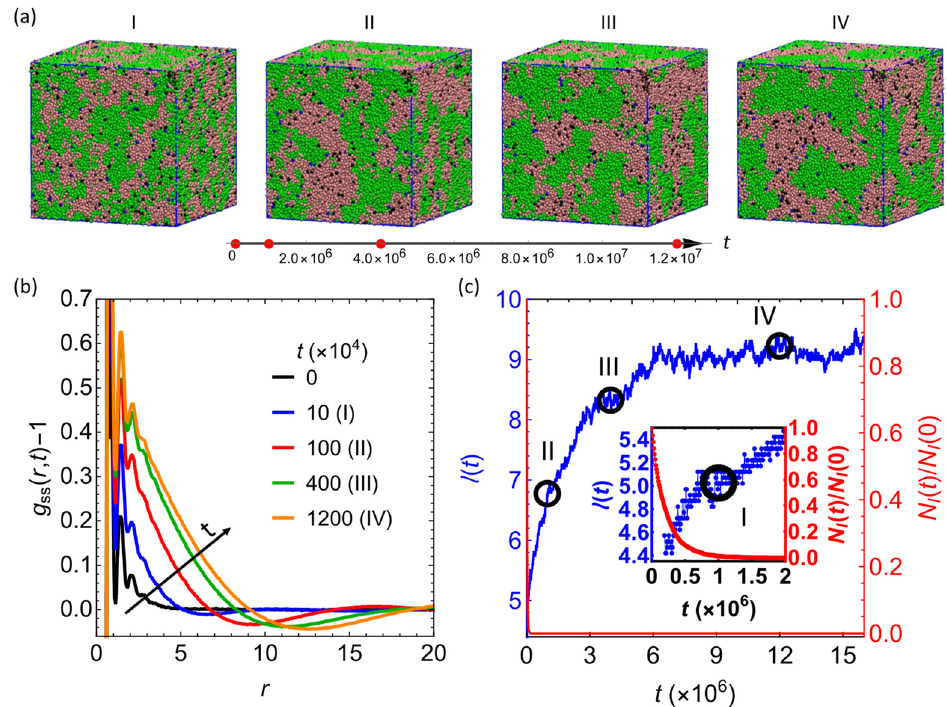
Figure 2. ( a ) Snapshots (I–IV) of the blend with f v − PDMS = 0.5 and N v − PDMS = 100. The time steps from the left to the right are 1 × 10 5 , 1 × 10 6 , 4 × 10 6 , and 1.2 × 10 7 . ( b ) The g ss ( r , t ) − 1 at various times as listed in the legend. ( c ) The time evolution of the characteristic length scale, l ( t ) , and the number of vinyl groups in the system normalized by the initial number of these groups, N I ( t ) / N I ( 0 ) . The time instances corresponding to the snapshots in ( a ) are marked by the open circles. The inset shows evolution at early times.